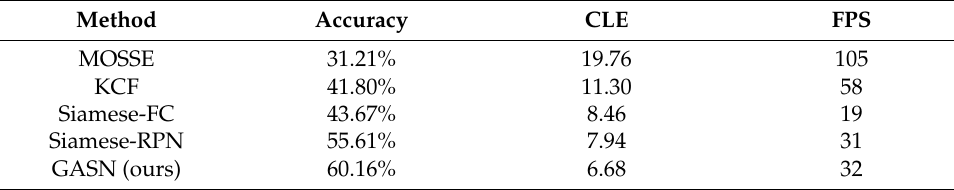
Figure 15. The comparison results of GASN with Siamese-RPN and Siamese-FC on FPS. Table 3. Average tracking performance of simulated Video-SAR data.